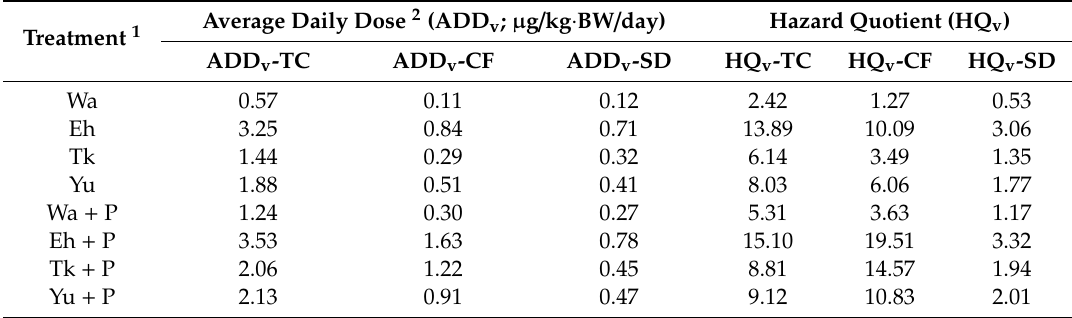
Table 4. Average daily dose (ADD) and hazard quotient (HQ) of the vegetable-to-human ingestion pathway (HQ v ) in water spinach grown in contaminated soils based on di ff erent assessment